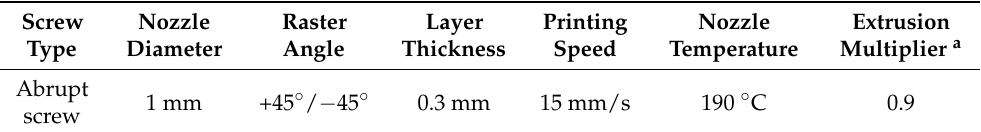
Table 1. Device and process parameters in the previous